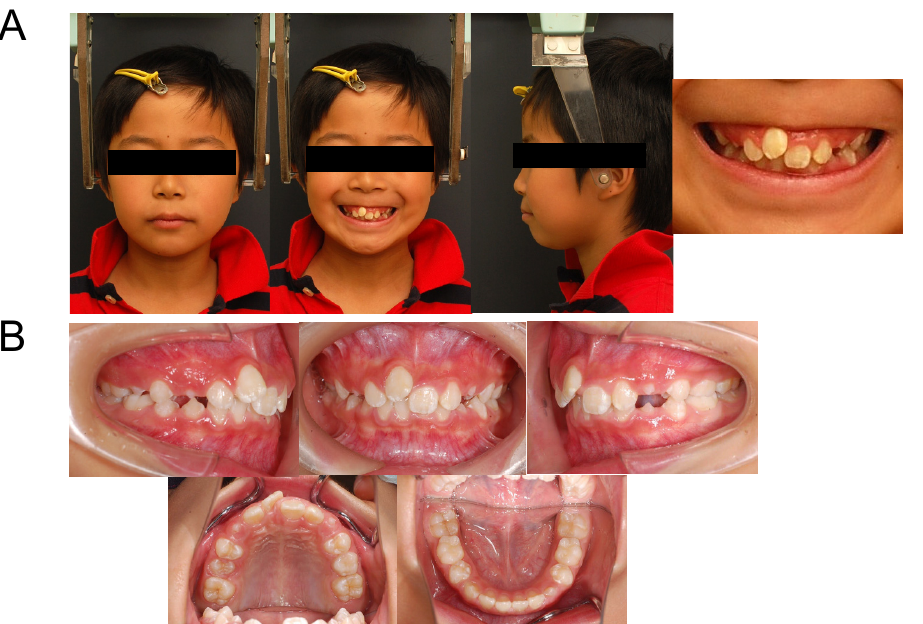
Figure 7. Facial photographs and intra-oral photographs at initial examination for Case 2; facial photograph and enlarged photograph of the mouth at initial examination ( A ); intra-oral photograph at initial examination ( B ).